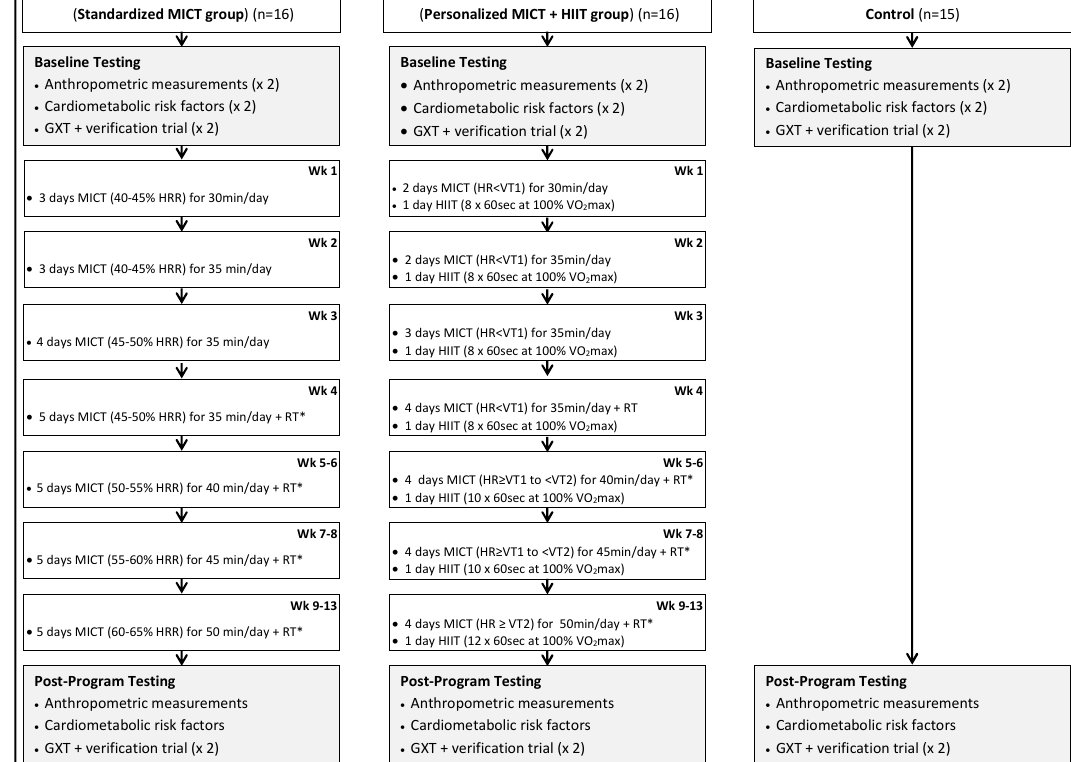
Figure 1. Experimental flow diagram and week-to-week exercise prescription for days/times of cardiorespiratory and resistance training. GXT = maximal graded exercise test; MICT = moderate intensity, continuous training; HIIT = high-intensity interval training; HR = heart rate; RT = resistance training; VT1 = ventilatory threshold 1; VT2 = ventilatory threshold 2; * RT performed 3 days/week.